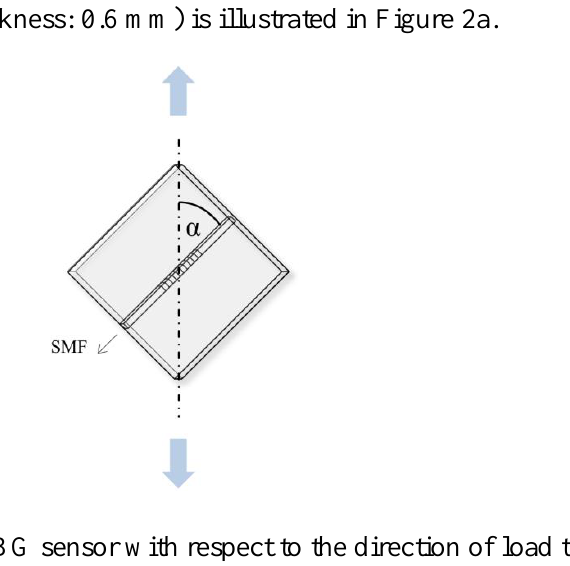
Figure 1. Orientation of the PPBG sensor with respect to the direction of load transmission (indicated by blue arrows).